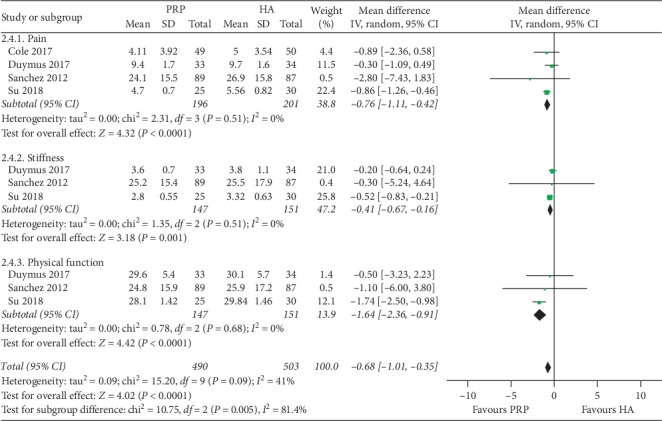
Forest plots showing the comparison of the effects of PRP and HA on WOMAC scores at 6th months of follow-up in overweight patients with knee OA.